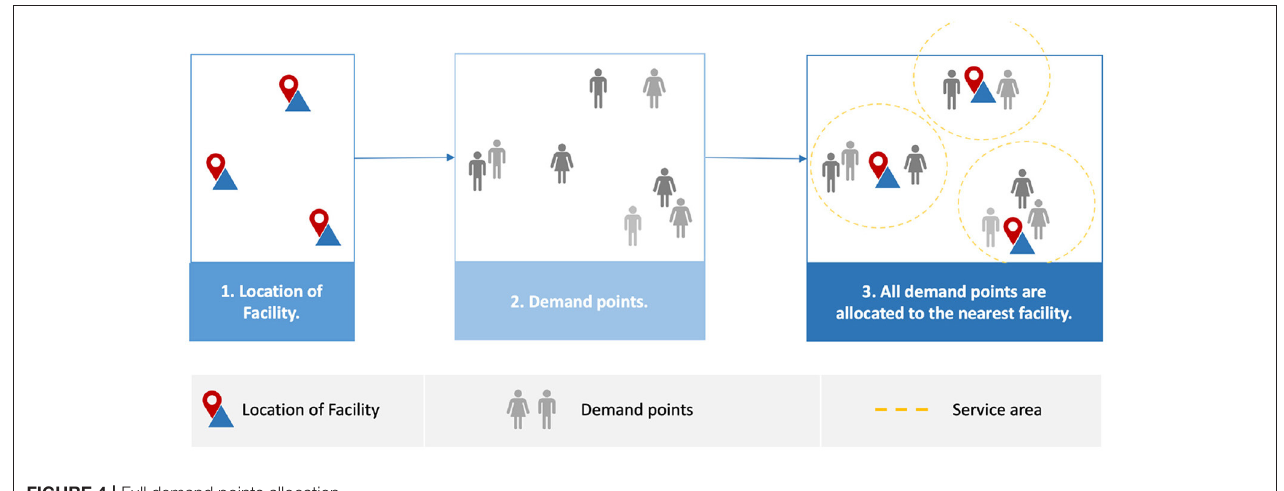
FIGURE 4 | Full demand points allocation.